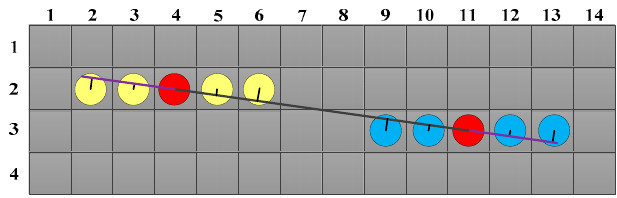
Figure 9. Connection of lines.